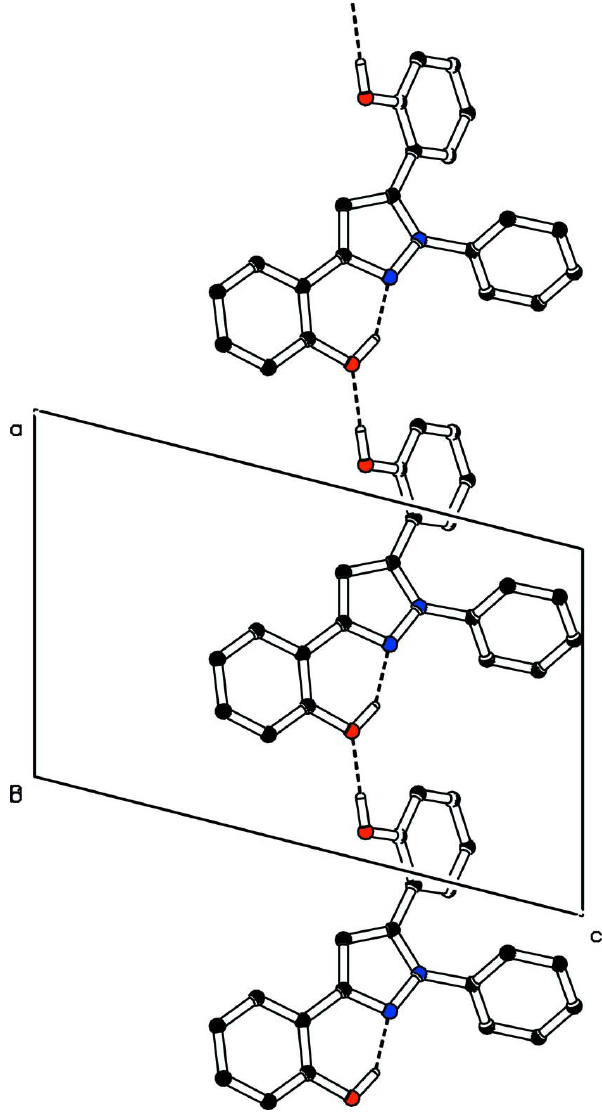
Part of the crystal structure of(I) showing the formation of a one-dimensional chain along [100] direction and the hydrogen-bonding and O-H···N intramolecular